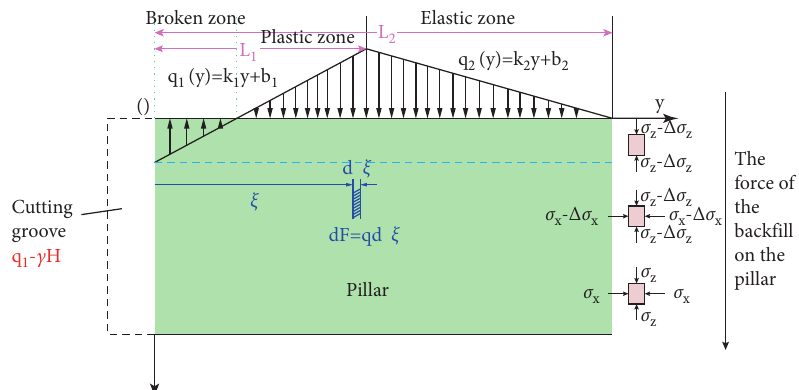
Figure 2: Mechanical model of cutting groove excavation unloading under filling